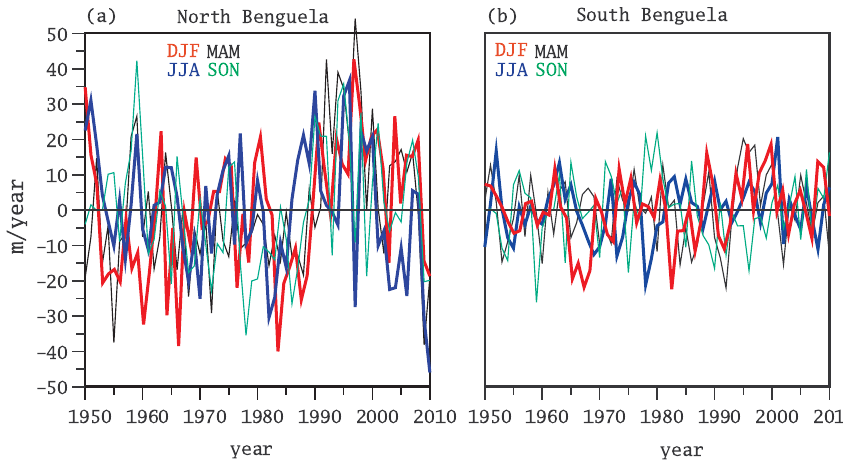
Figure 8. Time evolution of the seasonal upwelling indices (deviations from their long-term mean) in North Benguela (a) and South Benguela (b) derived from the vertical velocity of the STORM simulation in the period